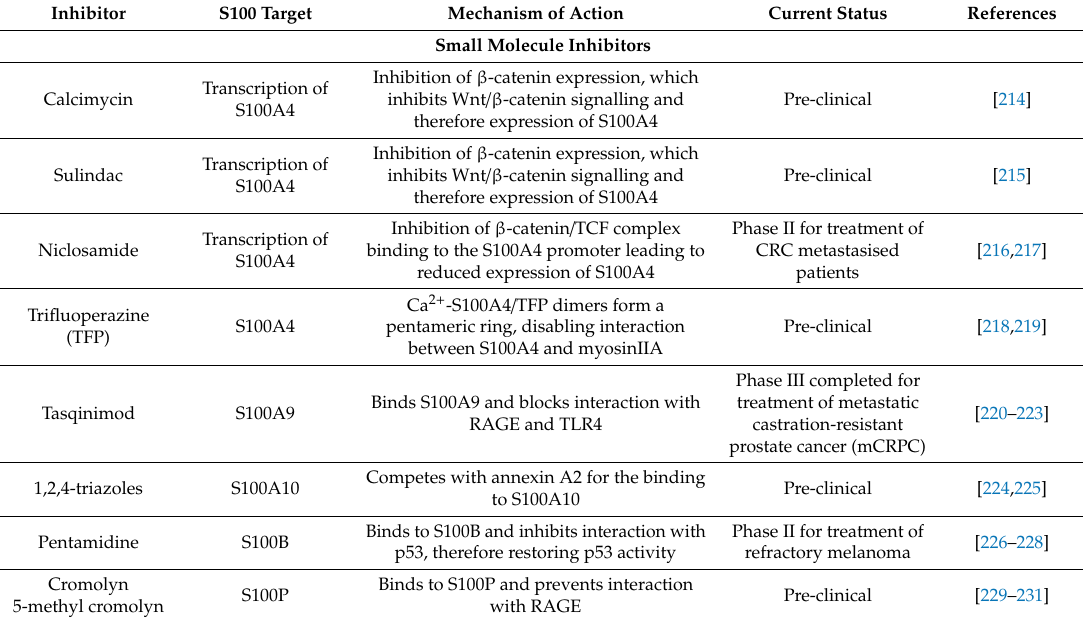
Table 1. Overview of potential S100